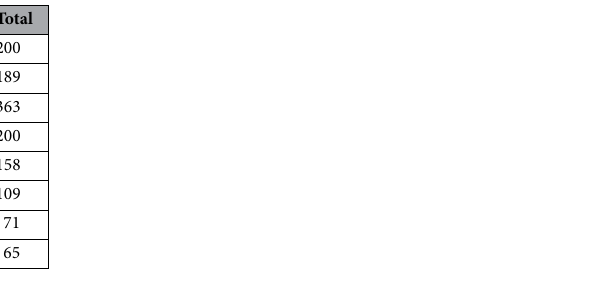
Table 1. Developed database age